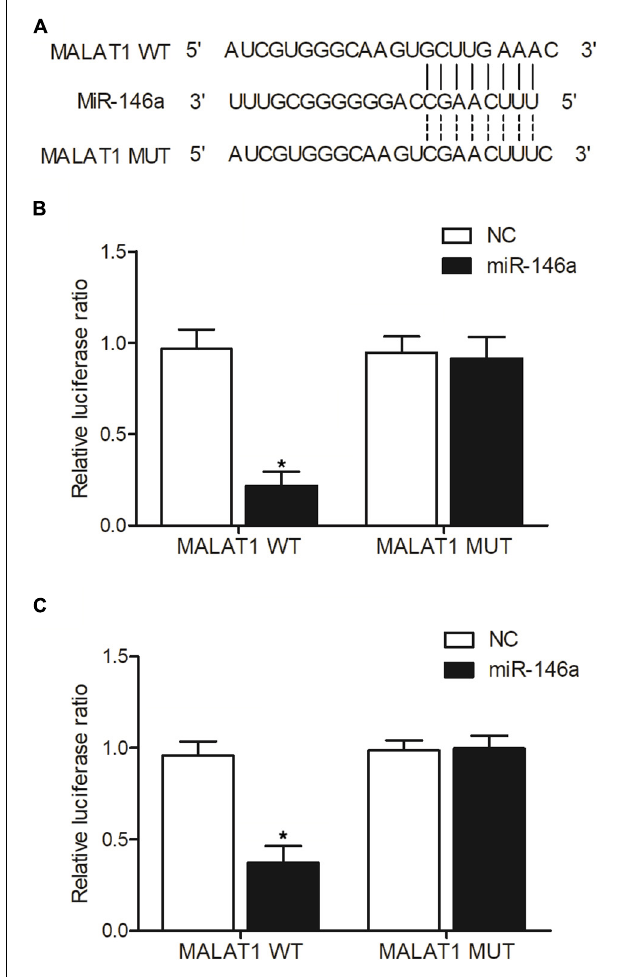
(A) Computational analysis of MALAT1 and miR-146a sequences. (B) Relative luciferase activity was reduced in hPASMCs co-transfected with wild-type MALAT1 and miR-146a. (C) Relative luciferase activity was reduced in rPASMCs co-transfected with wild-type MALAT1 and